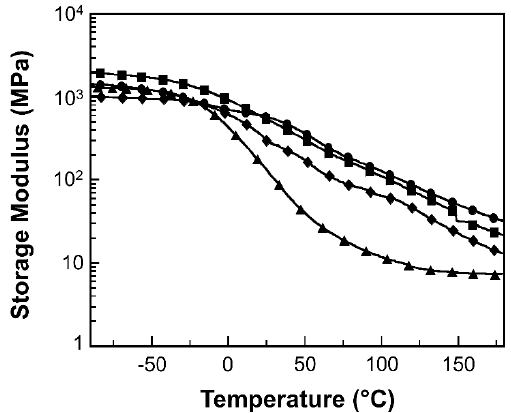
Figure 7. Storage modulus of MWCNT reinforced V-fa/ECO composites at various MWCNT contents of ( ● ) 0 wt%, ( ▲ ) 0.1 wt%, ( ■ ) 0.3 wt%, and ( ♦ ) 0.5 wt%.